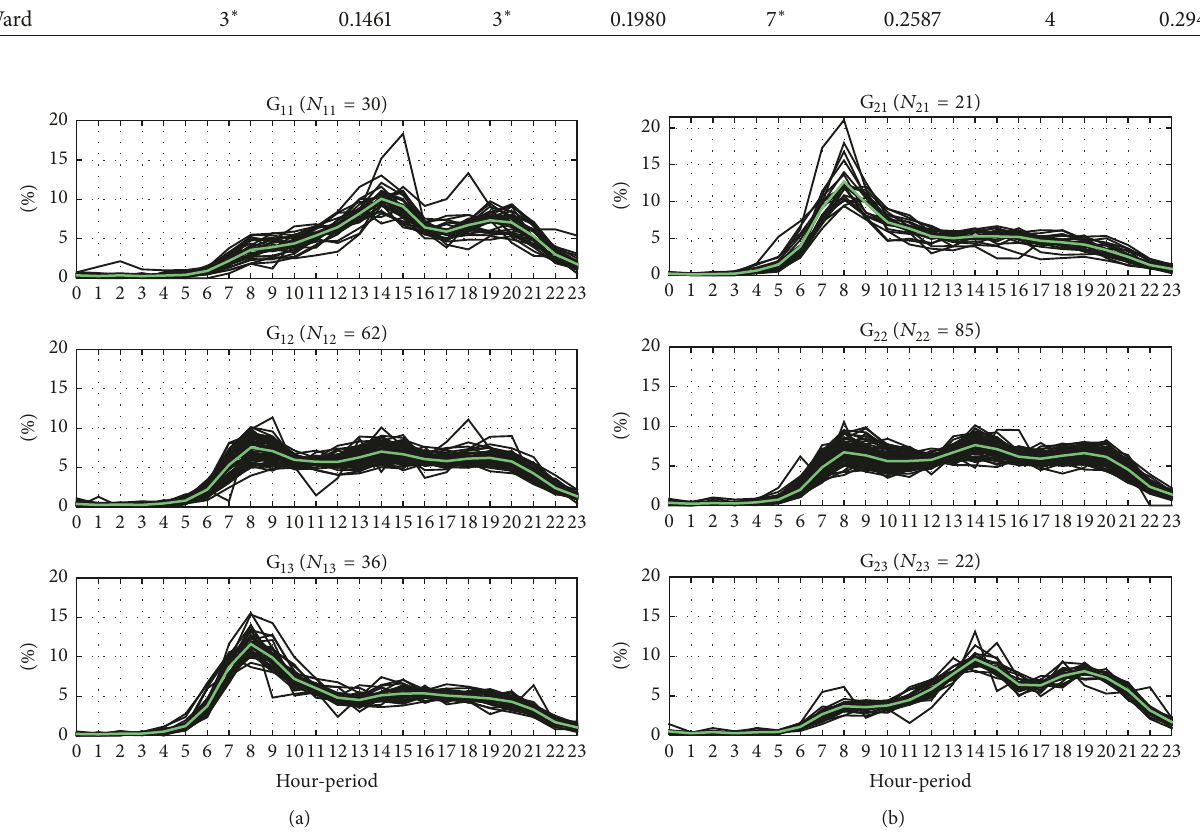
Figure 1: Weekday patterns by the hour period associated with (a) departure time from a given zone and (b) arrival time at zone (“8” refers to